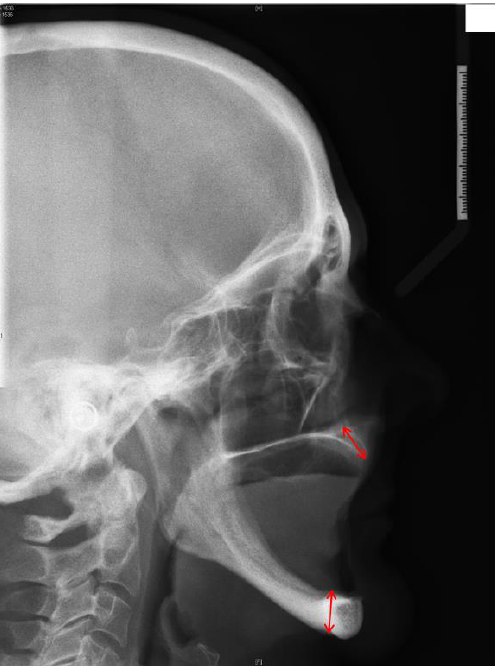
Figure 2. The red lines represent the height of the anterior part of maxillary ( top ) and mandibular arches ( bottom ).